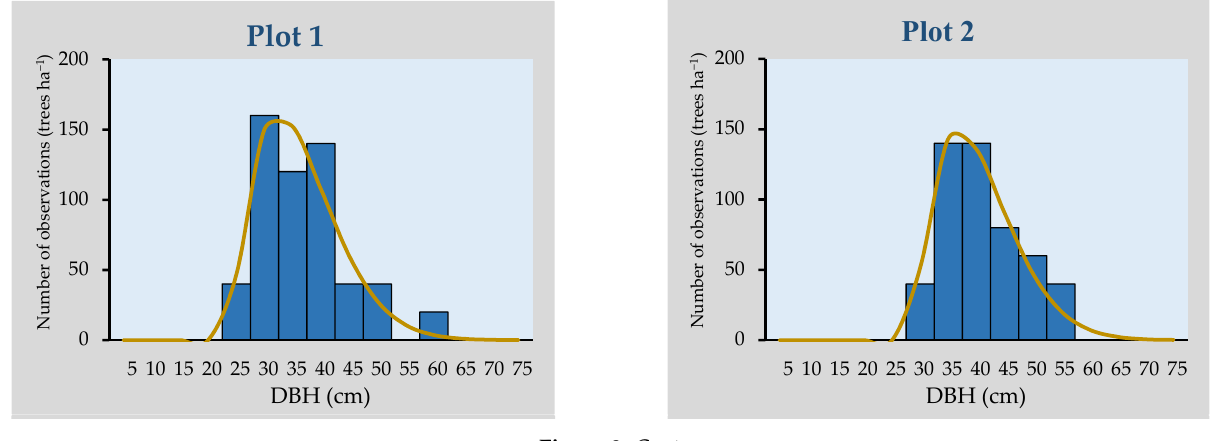
Figure 3. The relationship between the observation (bar) and predicted curve (line) for all plots.